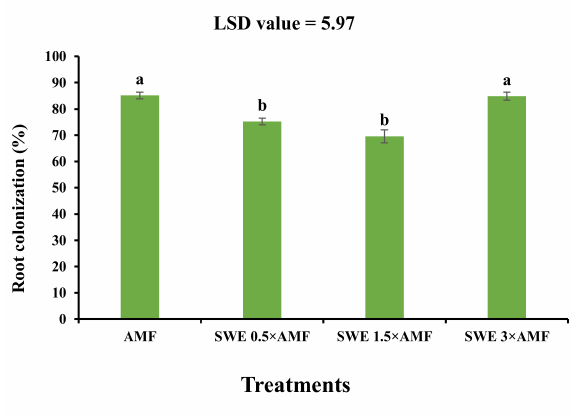
Figure 2. Mean root colonization percentage of lettuce plants affected by arbuscular mycorrhiza (AMF) inoculation × seaweed extract (SWE) foliar treatment. Different letters indicate significant differences at 5% level according to the least significant difference (LSD)